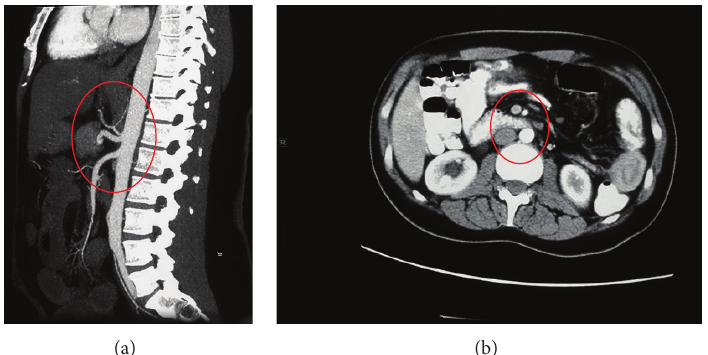
Figure 3: (a) and (b) Wide aortomesenteric angle and distance in a normal individual with no duodenal compression (red